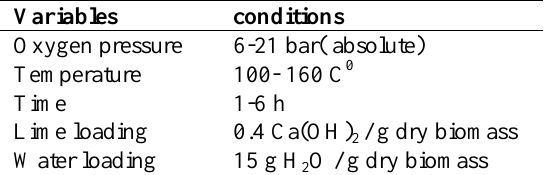
pretreatment conditions